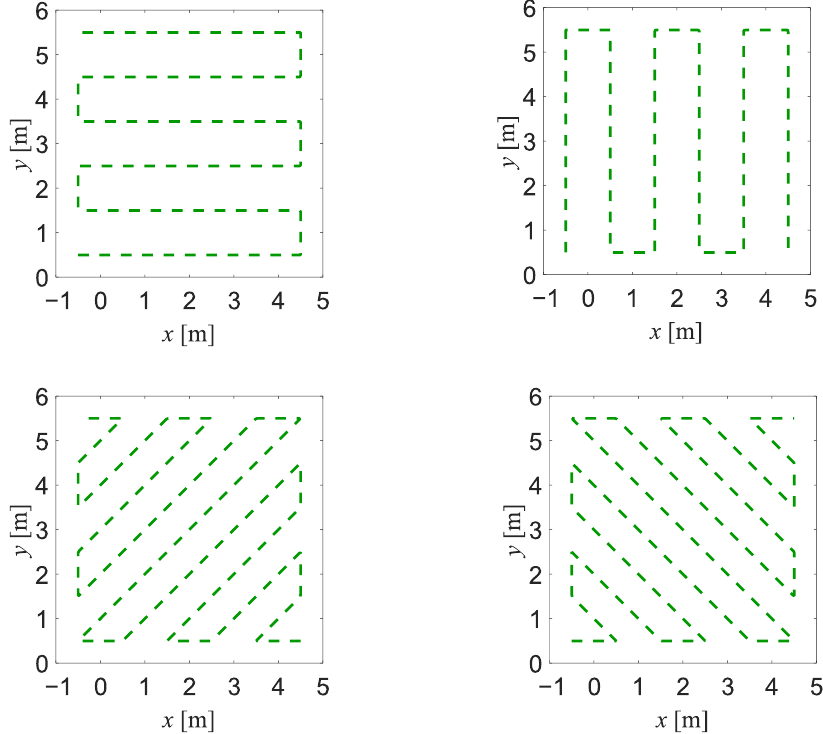
Figure 2. Reference trajectories used for generation of the synthetic data.